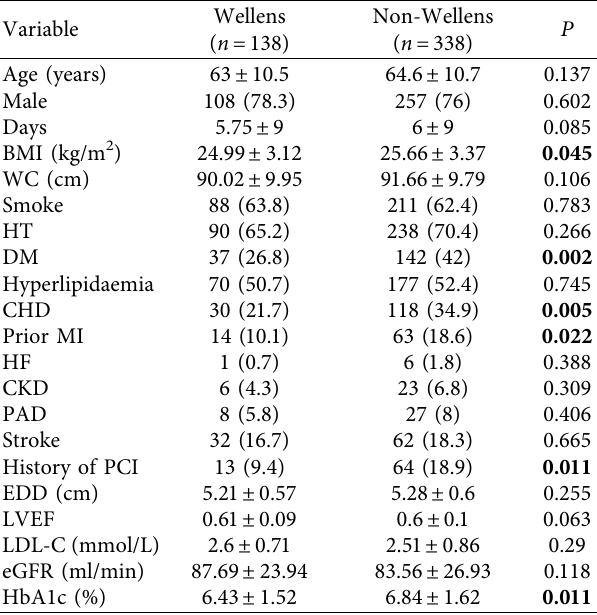
cardiac death ( P � 0 . 334) or MACCE ( P � 0 . 07). In Fig- ure 3, age ≥ 65 years was the largest predictive factor of cardiac death (HR: 3.55, 95% CI: 1.10–11.50) and poor